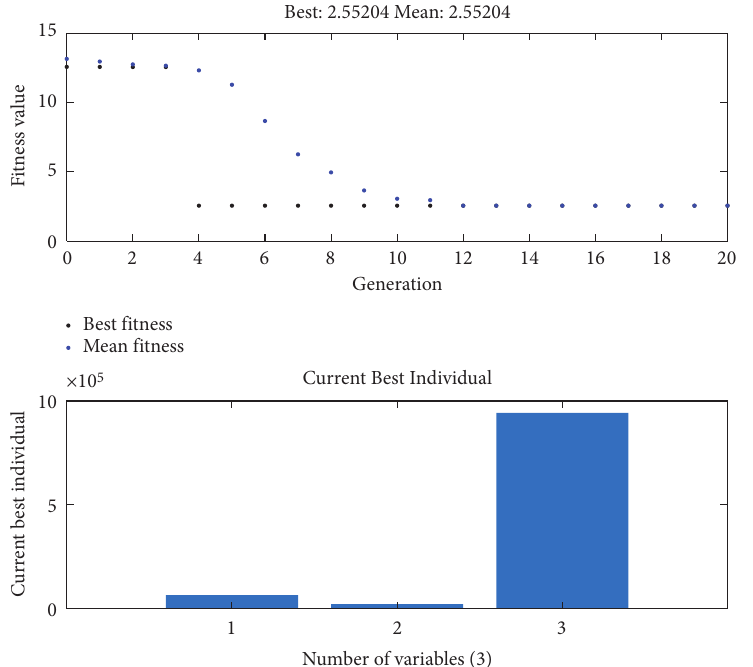
Figure 6: Parameter impact on the recommendation system.